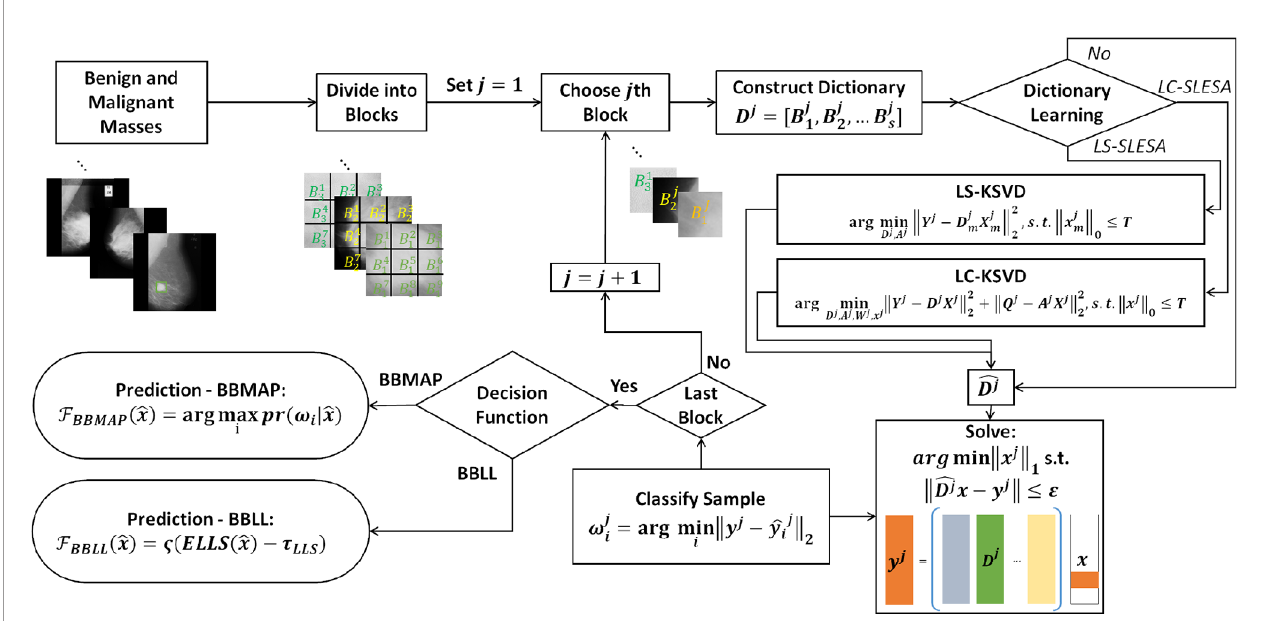
FIGURE 1 | Main stages of the proposed methodology; block decomposition, dictionary learning, and ensemble classi fi cation. ROIs of benign and malignant image samples are fi rst divided into blocks. Block dictionaries are constructed for each block index overall the training samples. Each block of a test image is classi fi ed using the corresponding block dictionary. If no dictionary learning is performed, our SLESA method is employed and an image is classi fi ed using an ensemble of its block classi fi cations. When dictionary learning is used, either through KSVD (our LS-SLESA method) or through LC-KSVD2 (our LC-SLESA method) the block dictionaries are learned to produce more discriminative dictionaries. Individual spatially localized decisions are combined to classify test samples using ensemble techniques BBMAP and BBLL-S or